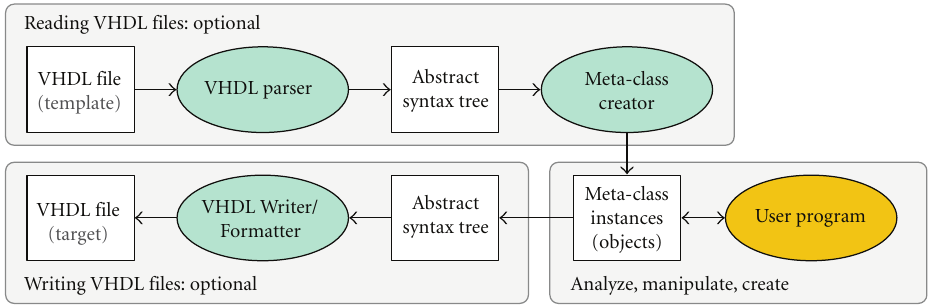
Figure 1: vMAGIC Designflow, reading and writing VHDL is optional. As such a vMAGIC application can be a pure VHDL generator or